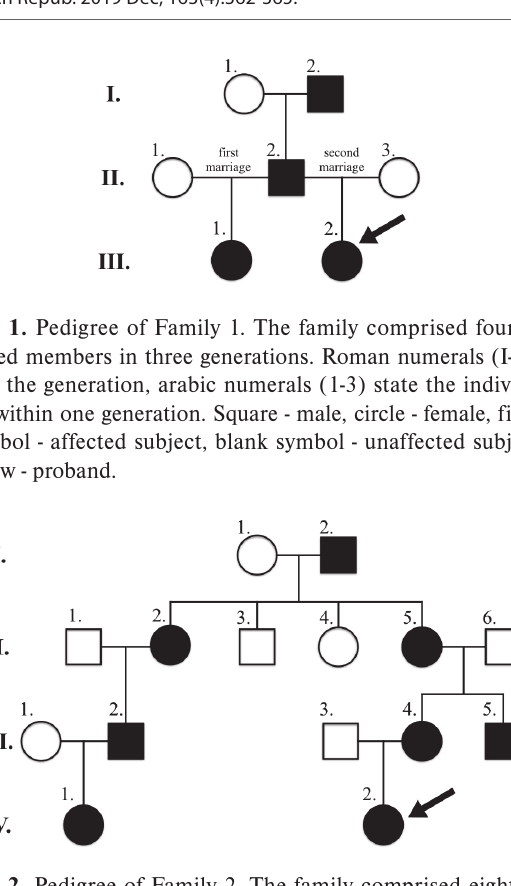
Fig. 2. Pedigree of Family 2. The family comprised eight af- fected members in four generations. Roman numerals (I-IV) give the generation, arabic numerals (1-6) state the individu- als within one generation. Square - male, circle - female, filled symbol - affected subject, blank symbol - unaffected subject, arrow - proband.